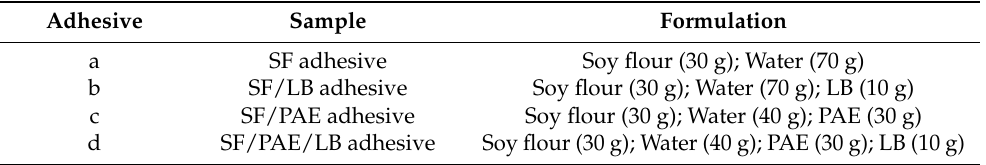
Table 1. Adhesive formulations. PAE: polyamidoamine-epichlorohydrin; LB: lignin-based resin; SF: soy